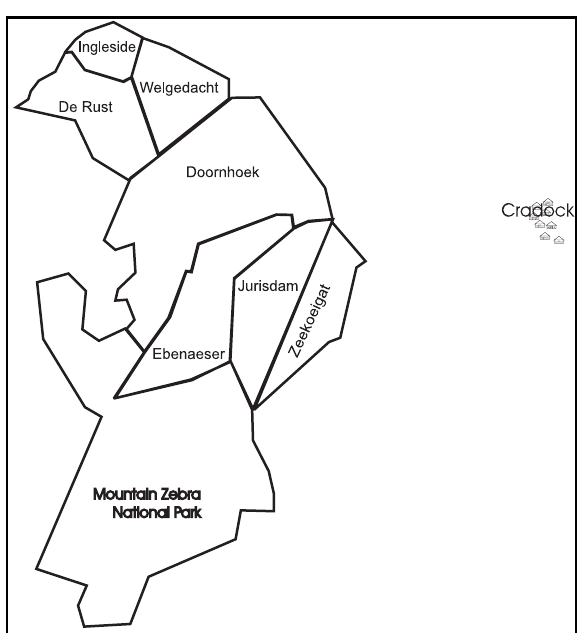
Figure 1. Location of the study